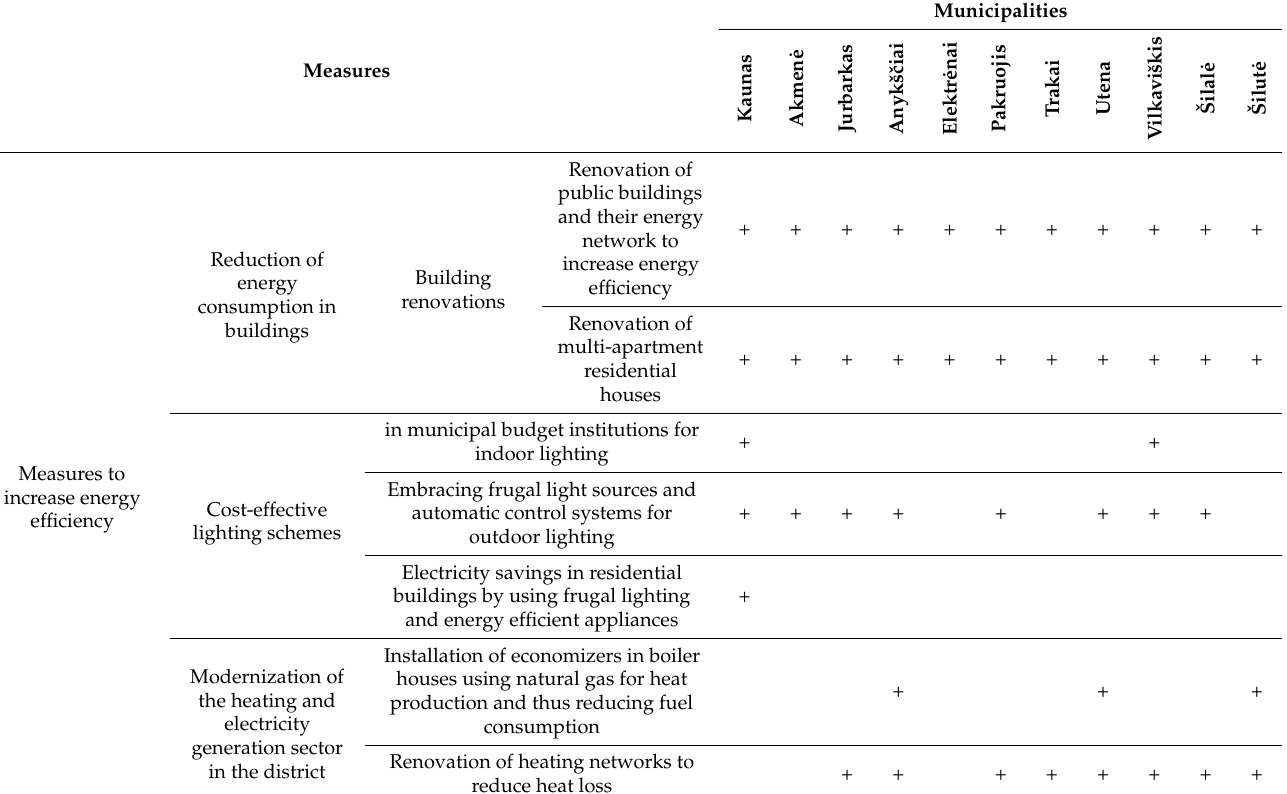
Table 2. Main measures for the climate change mitigation foreseen in Sustainable Energy Action Plans of Municipalities of